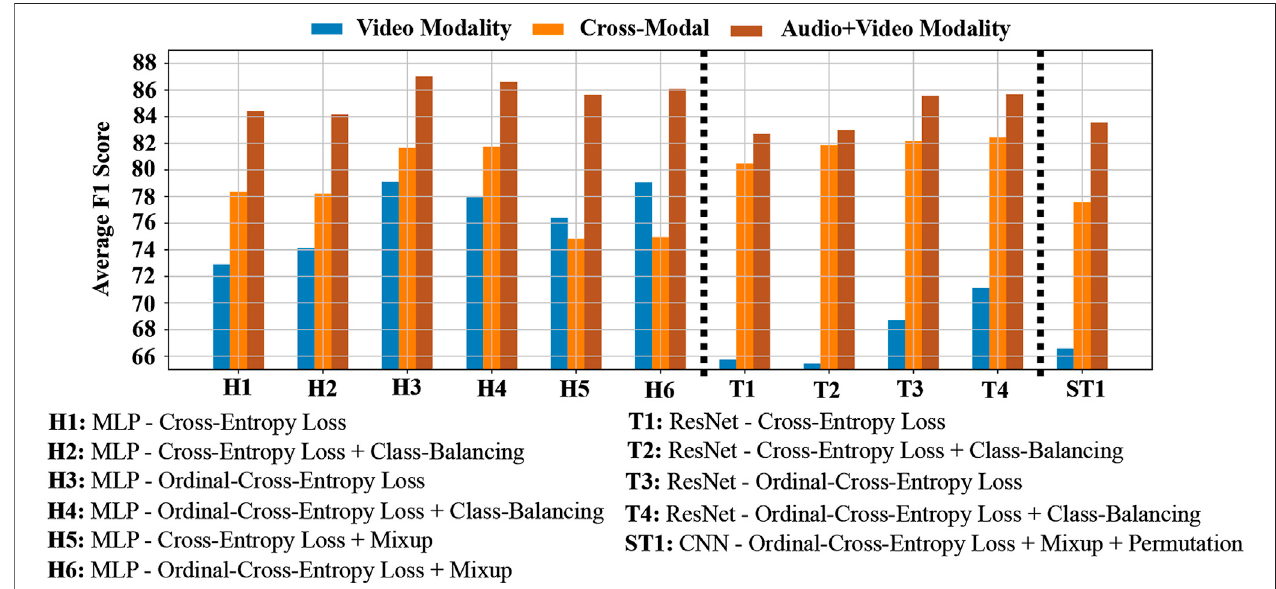
FIGURE 9 | Weighted F1-score performance of the different Level B2 features in the Video, Cross-modal and Audio + Video modality settings.